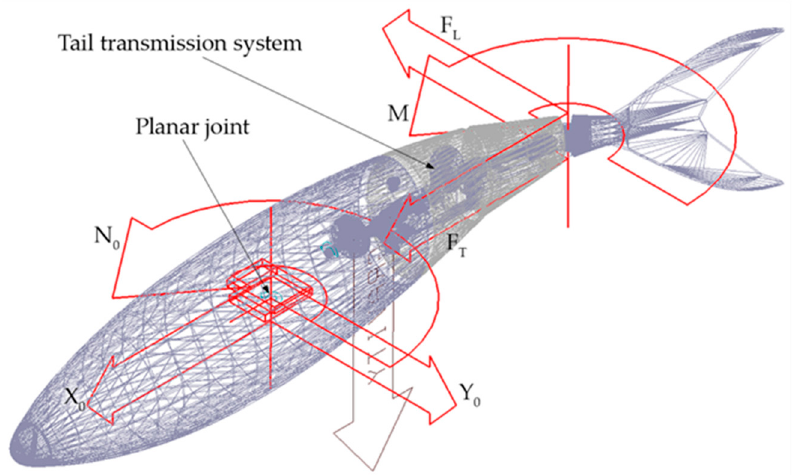
Figure 14. Multibody model of the carangiform swimming robot imported in Adams / View by MSC software ® .